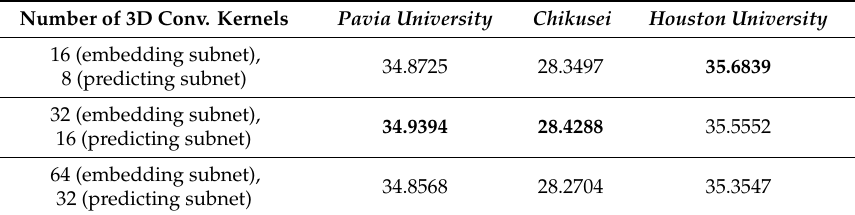
Table 7. PSNR (dB) indices of the sensitivity analysis of MW-3D-CNN over the number of 3D convolutional kernels in embedding and predicting subnets. The upscaling factor is two. Number of 3D Conv. Kernels